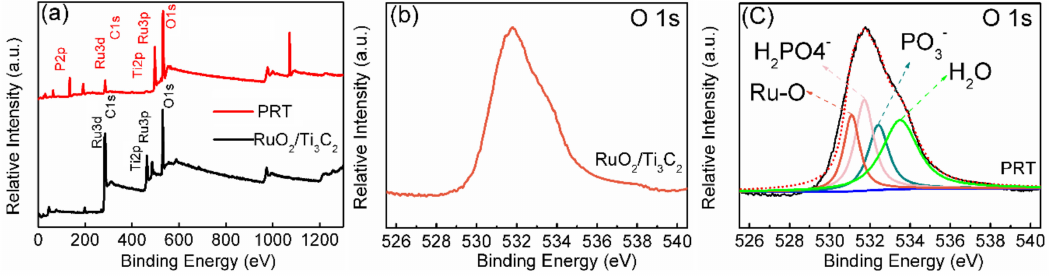
Figure 3. ( a ) X-ray photoelectron spectroscopy (XPS) survey of RuO 2 /Ti 3 C 2 and PRT. High-resolution O1s XPS spectrum of ( b ) RuO 2 /Ti 3 C 2 and ( c )